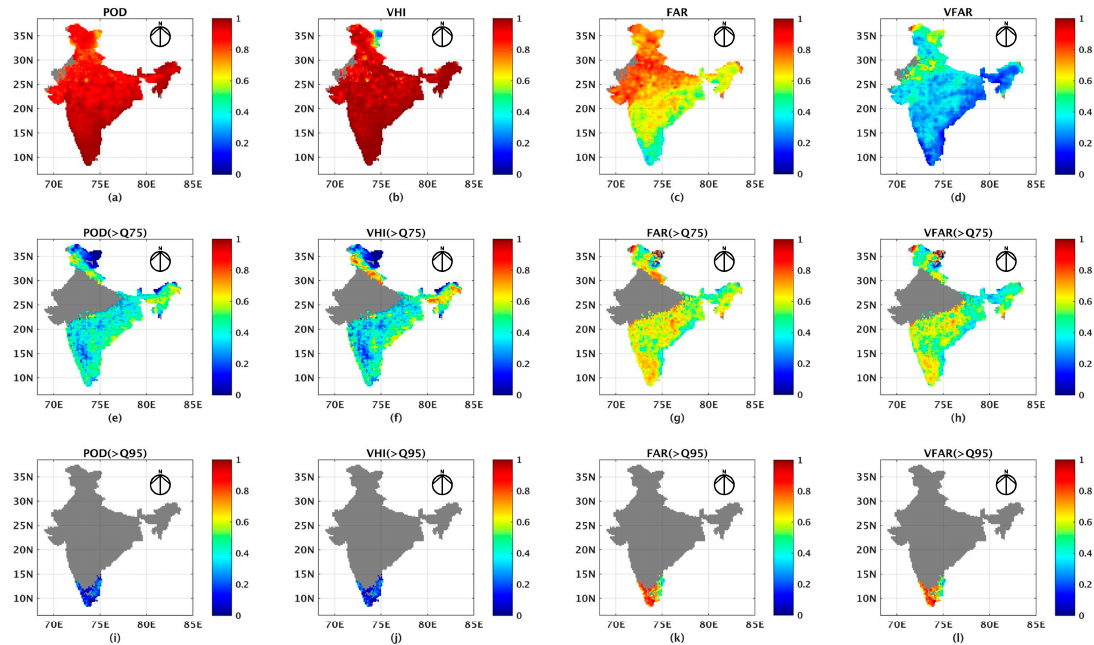
Figure 10. ( a – l ) Spatial distribution of categorical indices for the ON months over India for daily and higher quantiles of precipitation using MSWEP and IMD daily precipitation data from 1979 to 2013 showing POD ( a , e , i ); VHI ( b , f , j ); FAR ( c , g , k ); and VFAR ( d , h , l ).